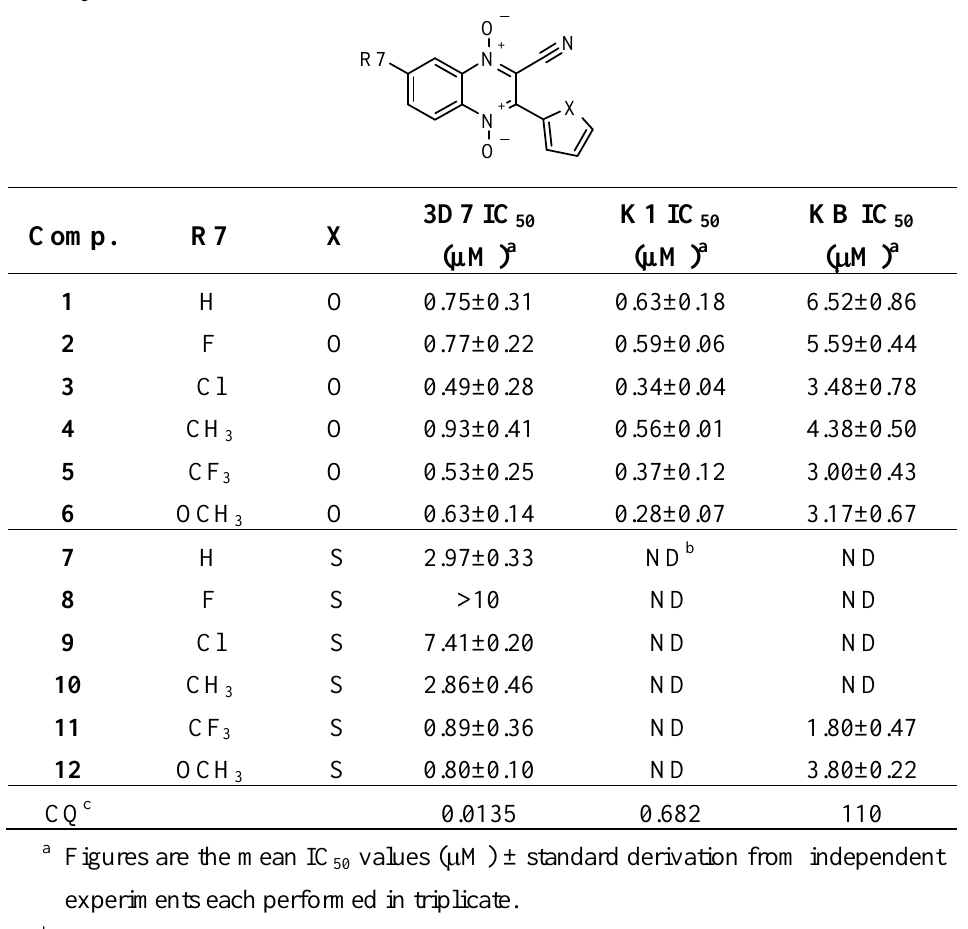
Table 1. Structures, in vitro activity against P. falciparum (3D7 and K1 strains) and cytotoxicity in mammalian KB